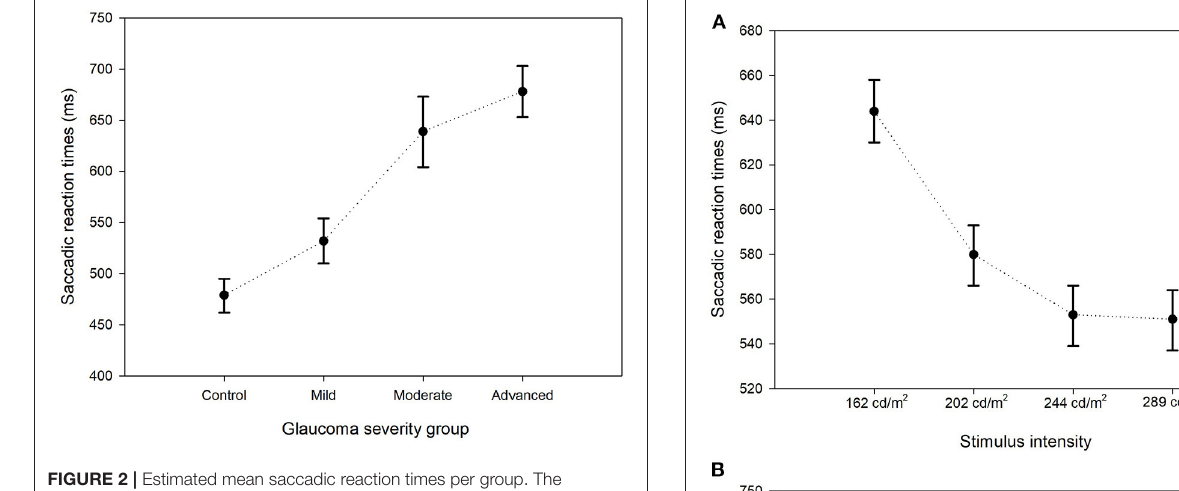
Figure 4B , the corresponding SRT values have been plotted for the SAP sensitivity bins, again stratified by glaucoma